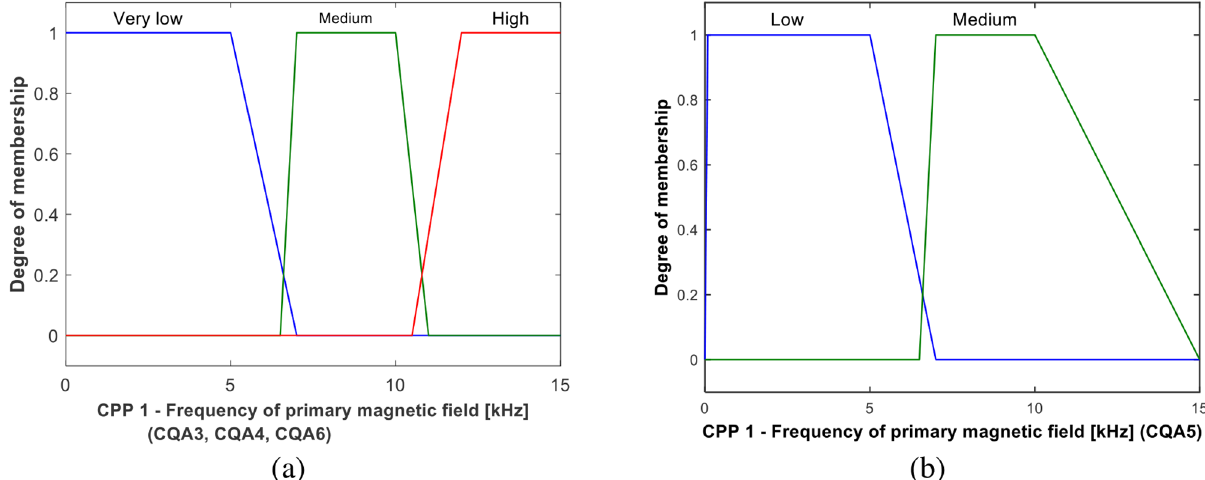
Fig. 6. Membership function for CPP 1 . (a) Fuzzy input 1 – CPP 1 related to CQA 3 , CQA 4 , CQA 6 ; (b) Fuzzy input 2 – CPP 1 related to CQA 5 .